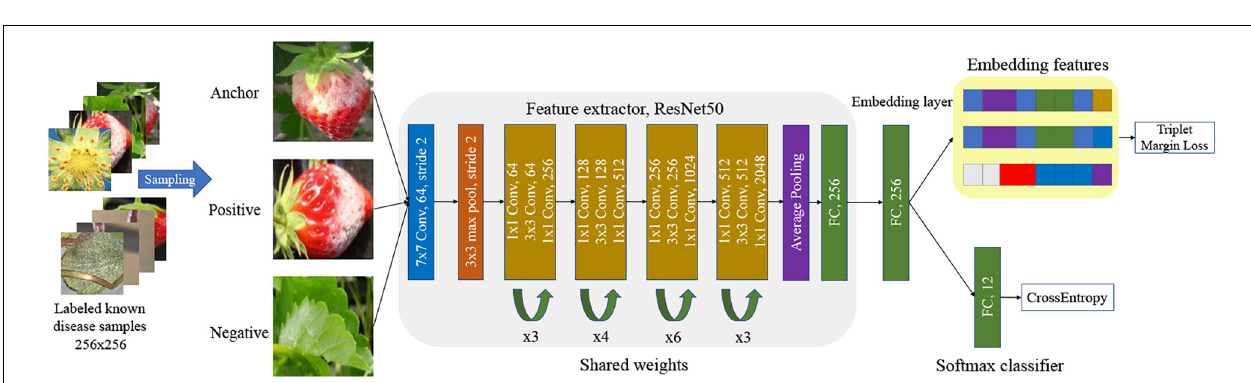
FIGURE 3 | Triplet network and loss with softmax